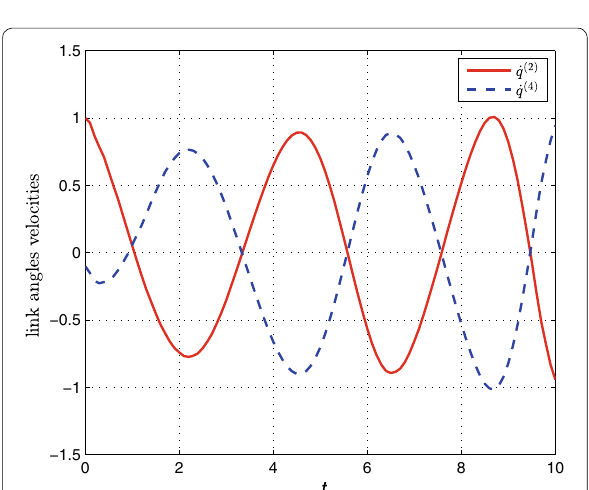
Figure 11 Histories of constrained link angles